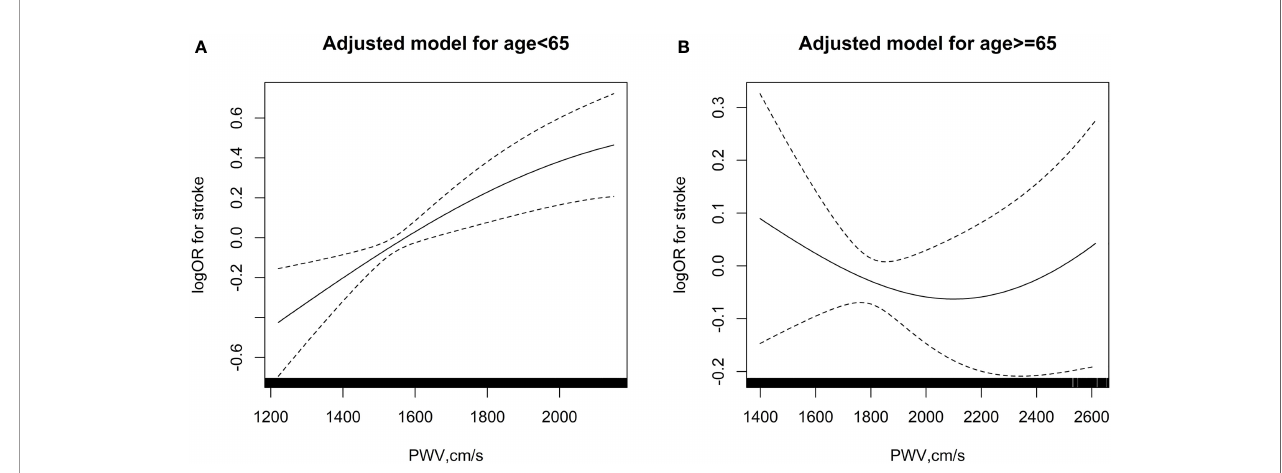
FIGURE 1 | The association between baPWV and risk of fi rst stroke in various age groups. (A) age < 65 years; (B) age ≥ 65 years. The splines were adjusted for age, sex, body mass index, systolic blood pressure, diastolic blood pressure, smoking status and alcohol consumption, baseline fasting blood glucose, total cholesterol, triglycerides, homocysteine and history of antihypertensive drug